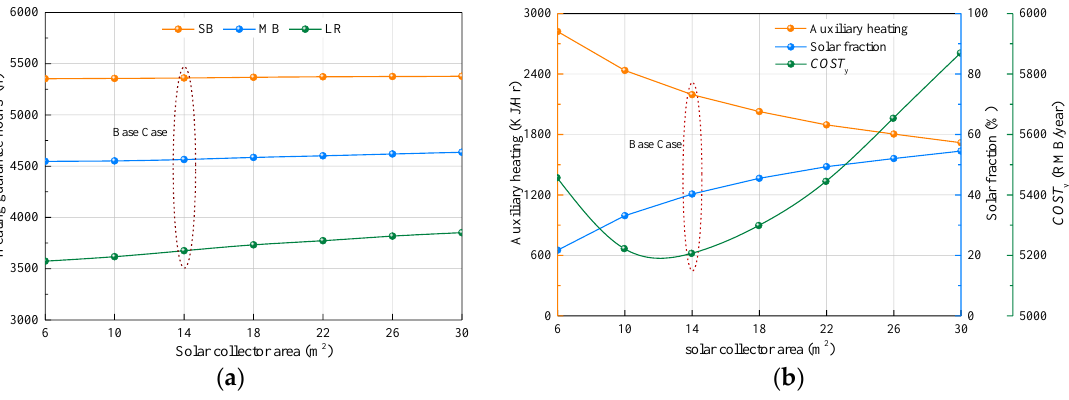
Figure 8. Optimized analysis of different solar collector area. ( a ) Heating effect; ( b ) system performance evaluation.